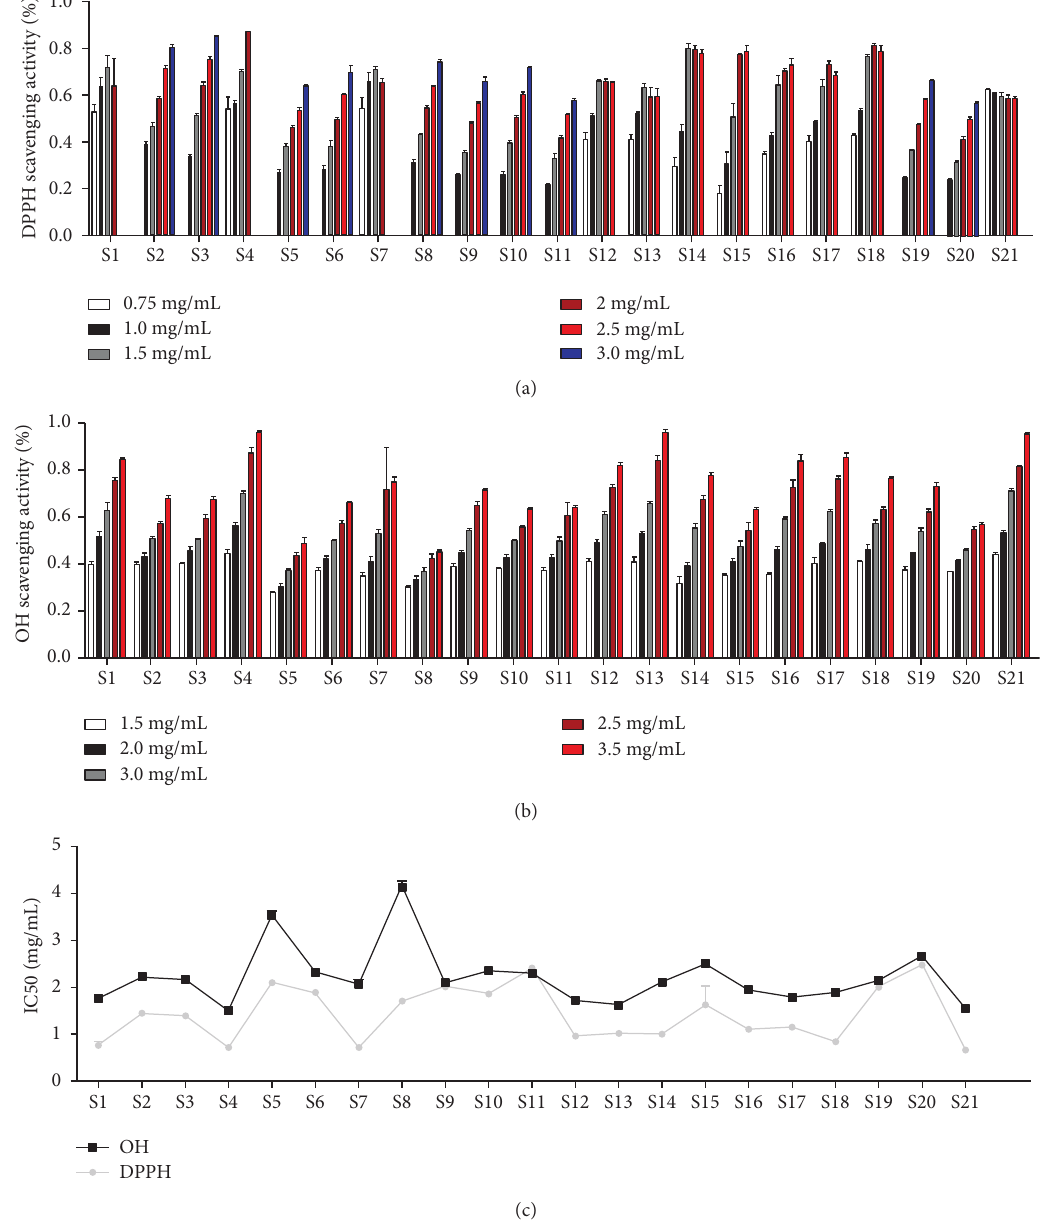
50 of the antioxidant activity of